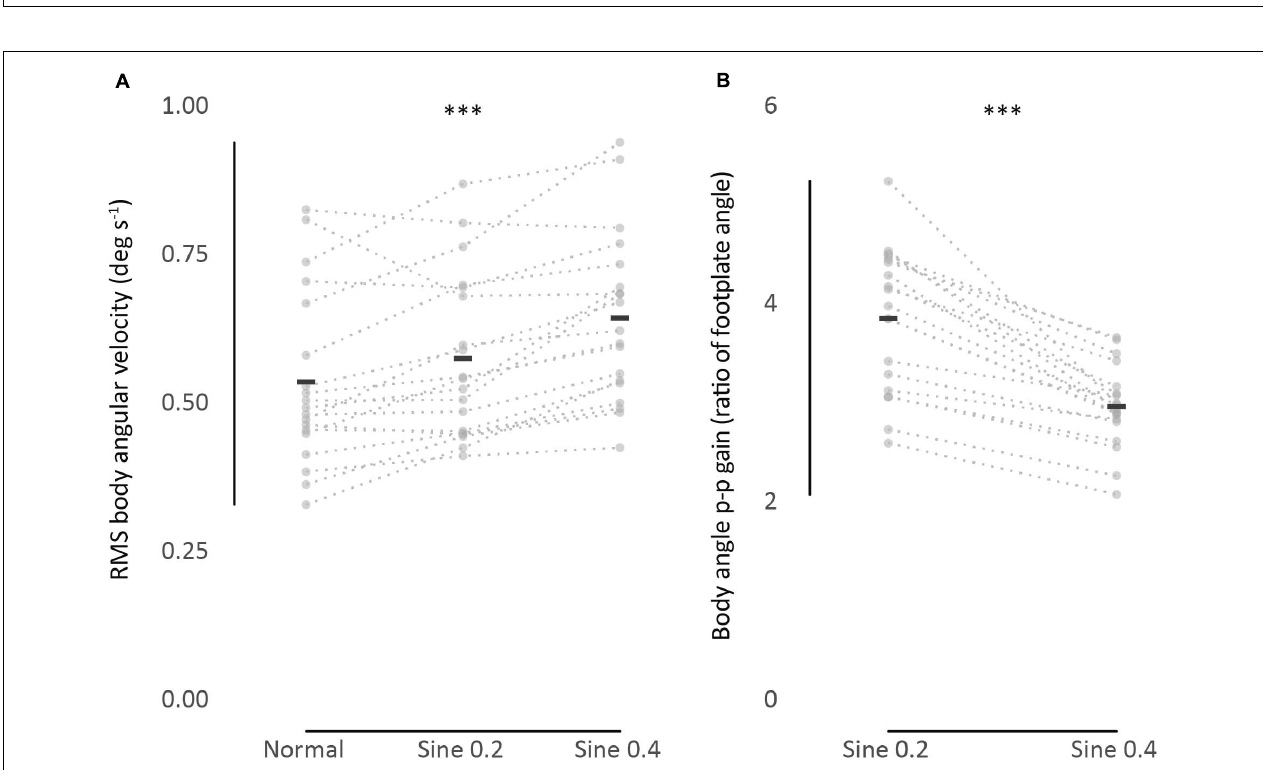
FIGURE 2 | (A) RMS body angular velocity. (B) Body angle p-p gain (ratio of body to footplate angle). Univariate scatter plot for different standing conditions, average from 2 trials (gray dots). Black bars indicate mean values. Dotted lines connect data from each participant. ∗∗∗ P < 0.001.